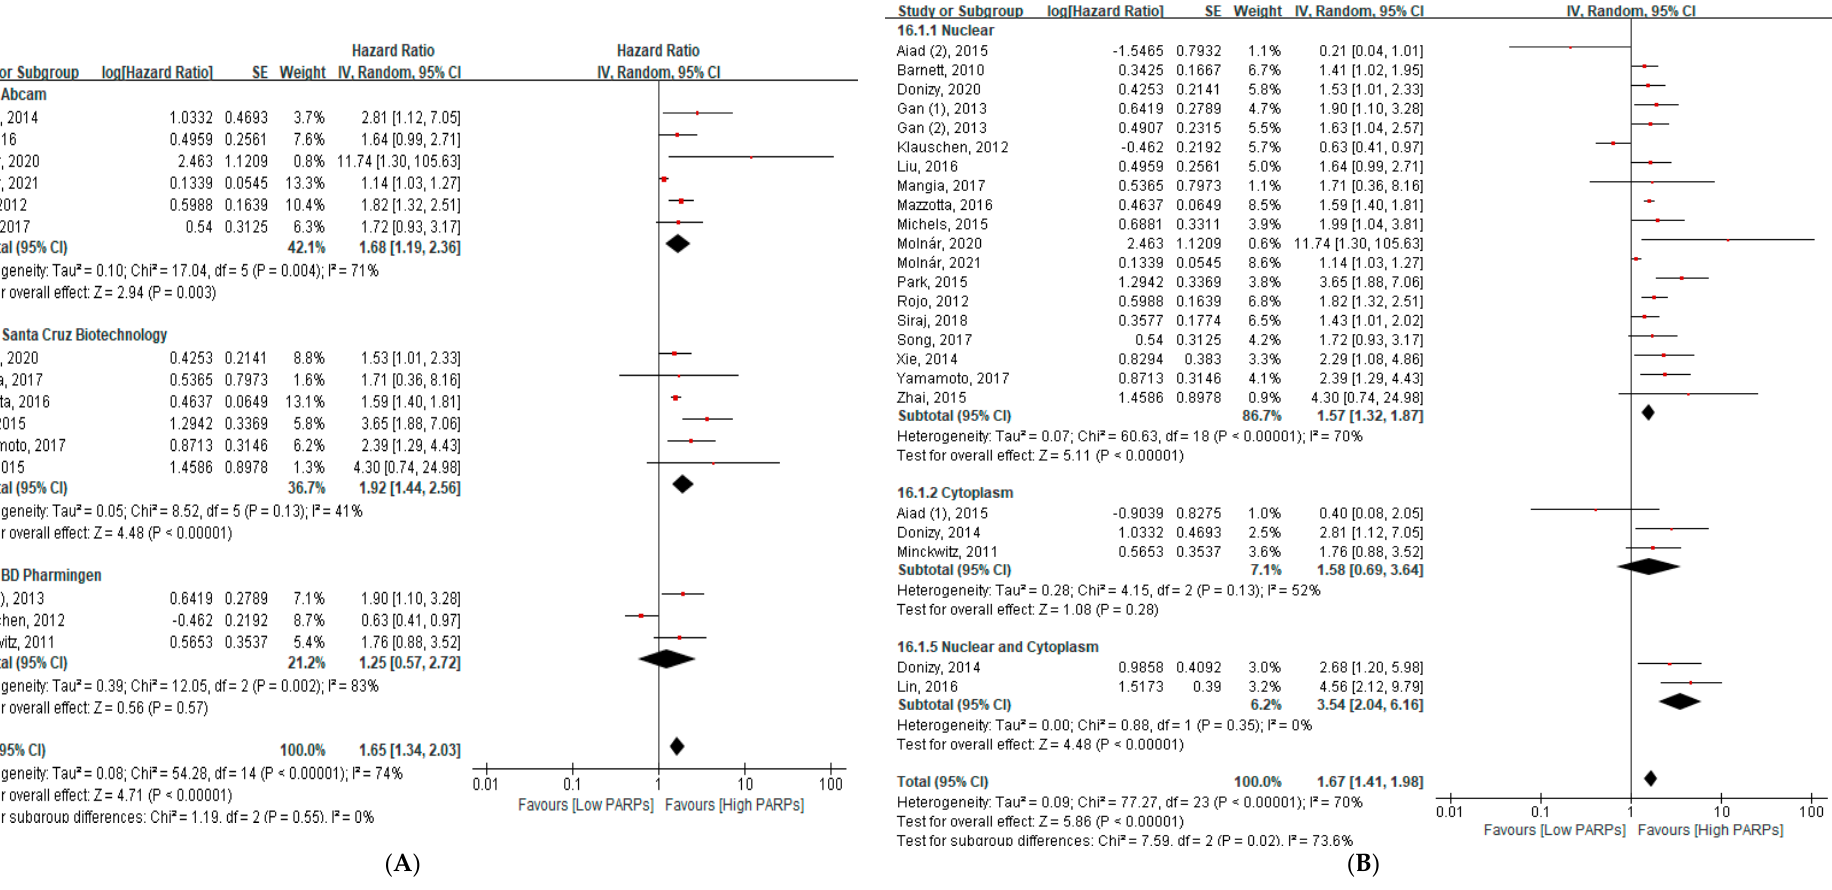
Figure 4. The subgroup analysis between the PARP expression and overall survival ( A ) according to the antibody clones and ( B ) immunoreactivity location-wise.